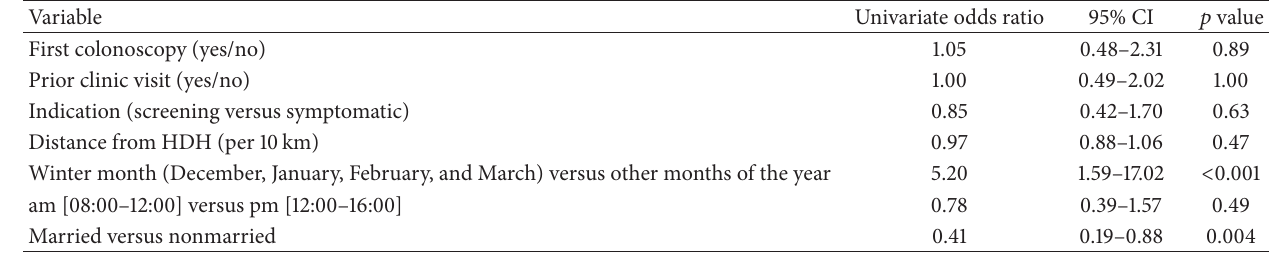
Table 2: Comparison of nonattenders to age and sex matched controls.